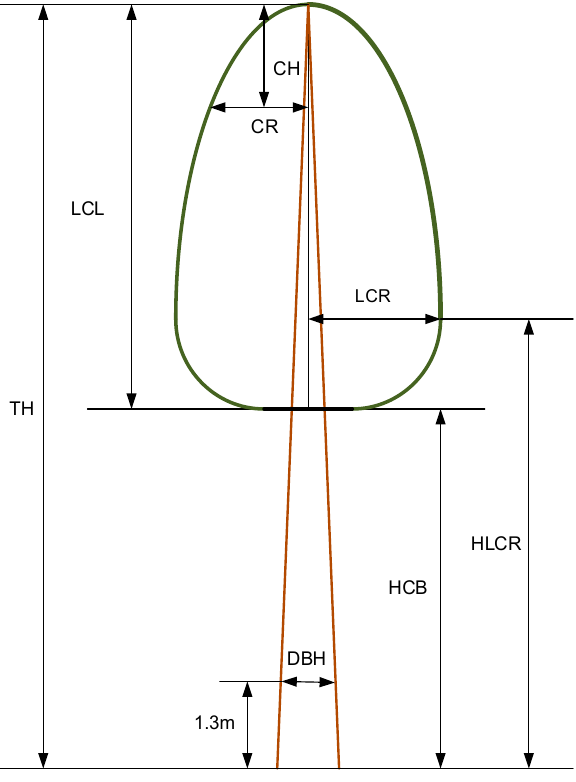
Figure 1. Tree crown measurement diagram for Chinese fir.